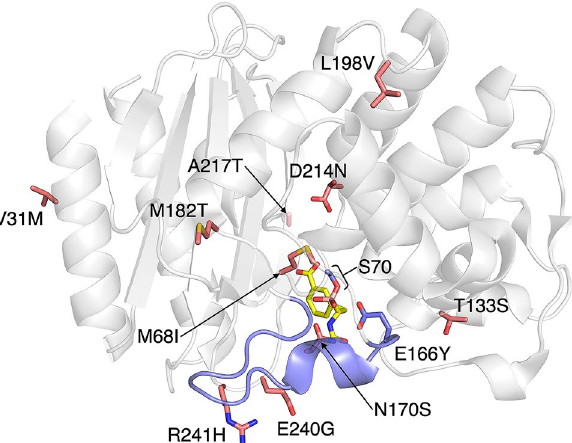
Figure 3. Distribution of the YR5-2 mutations in a three-dimensional structure of the wild-type TEM β-lactamase (PDB ID: 1ERM) 36 . The Glu166, Ser70, and the Ω loop are shown in purple. Mutated residues in YR5-2 are shown in pink. The boronic acid transition state analog is shown in yellow. The S4T mutation, which is located in the signal sequence, is not shown. The figure was prepared using PyMOL 37